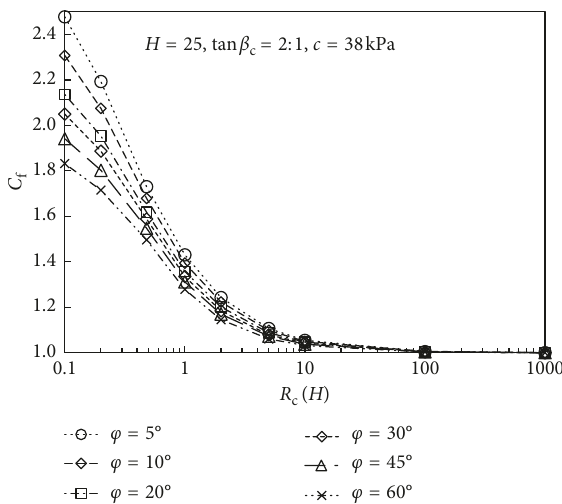
Figure 9: C f versus R c / H for different soil friction